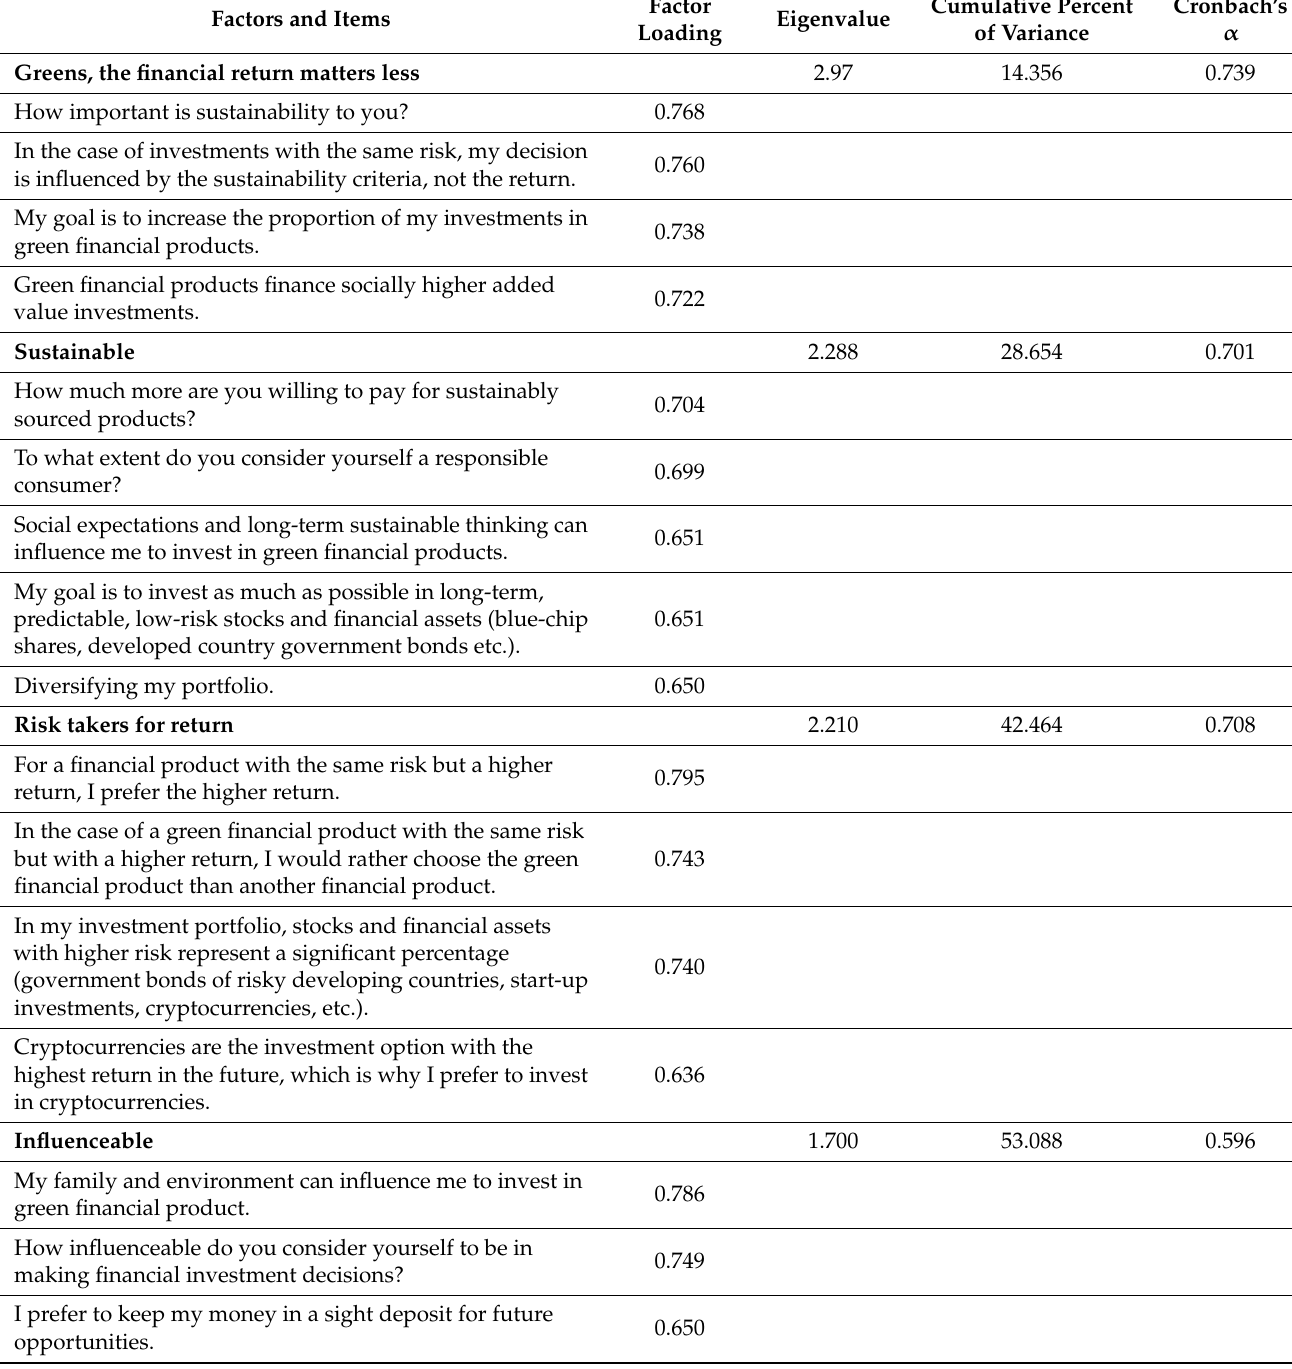
Table 2. Factor analysis of retail consumption of green financial